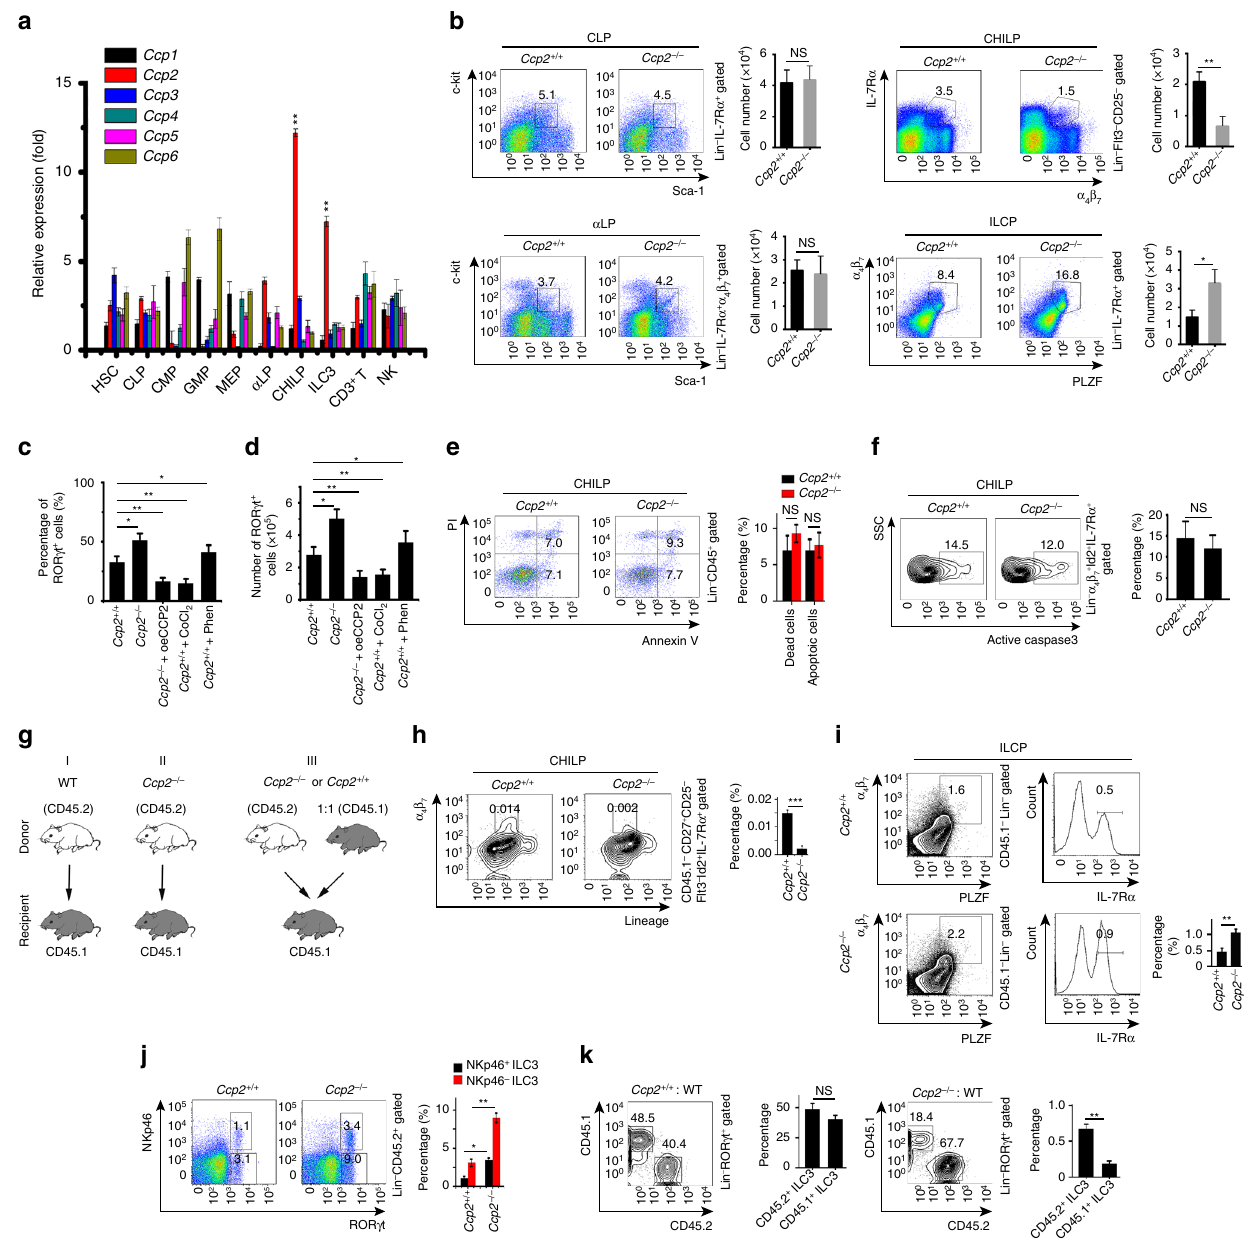
Fig. 2 CCP2 de fi ciency potentiates ILC3 differentiation from CHILPs. a Total RNAs were extracted from hematopoietic populations. Indicated gene expression levels of Ccp1 , Ccp2 , Ccp3 , Ccp4 , Ccp5 , and Ccp6 were examined by real-time qPCR. b Gating strategies and fl ow cytometry analysis of CLP (Lin − IL-7R α + Sca-1 low c-Kit low ), α LP (Lin − IL-7R α + Sca-1 + c-Kit + α 4 β 7 + ), CHILP (Lin − IL-7R α + Flt3 − CD25 − α 4 β 7 + ), and ILCP (Lin − IL-7R α + α 4 β 7 + PLZF + ) in BM from Ccp2 +/+ and Ccp2 − / − mice. n = 6 per group. Numbers of indicated cells in Ccp2 +/+ and Ccp2 − / − mice were calculated as shown means ± s.d. c , d CHILPs were isolated from Ccp2 +/+ or Ccp2 − / − mice and cultured on OP9 cells in the presence of SCF and IL-7 for 12 days. Percentages c and total numbers d of ILC3s were examined by fl ow cytometry, gated on CD45 + Lin − ROR γ t + . The CCP agonist CoCl 2 (10 μ m) and antagonist Phen (2 μ m) were added for in vitro differentiation assays. e Apoptosis of CHILPs from Ccp2 +/+ and Ccp2 − / − mice was analyzed with Annexin V/PI. Apoptotic cells were calculated and shown as means ± s.d. f Active caspase 3 in CHILPs from Ccp2 +/+ and Ccp2 − / − mice was detected by fl ow cytometry. g Schematic representation for BM transplantation assays. h – j 5 × 10 4 CD45.2 + LSK from Ccp2 +/+ or Ccp2 − / − mice with 5 × 10 6 CD45.1 + helper cells were transplanted into lethally